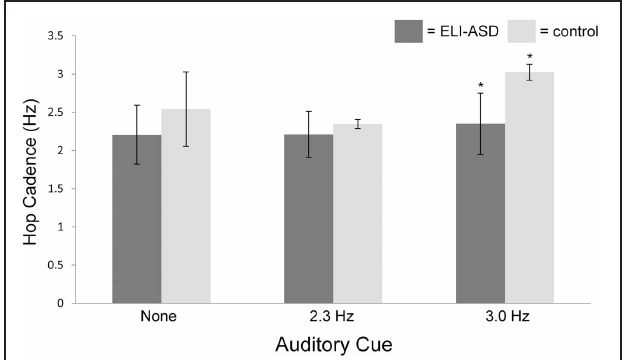
FIGURE 3 | Hop cadence vs. auditory cue (none, 2.3Hz, 3.0Hz). The control group was successful in 95% of trials in matching auditory cue while the ELI-ASD group was successful in only 33% of cued trials. The control group was significantly better at matching the 3.0Hz auditory cue than the ELI-ASD group ( p < 0 . 05).